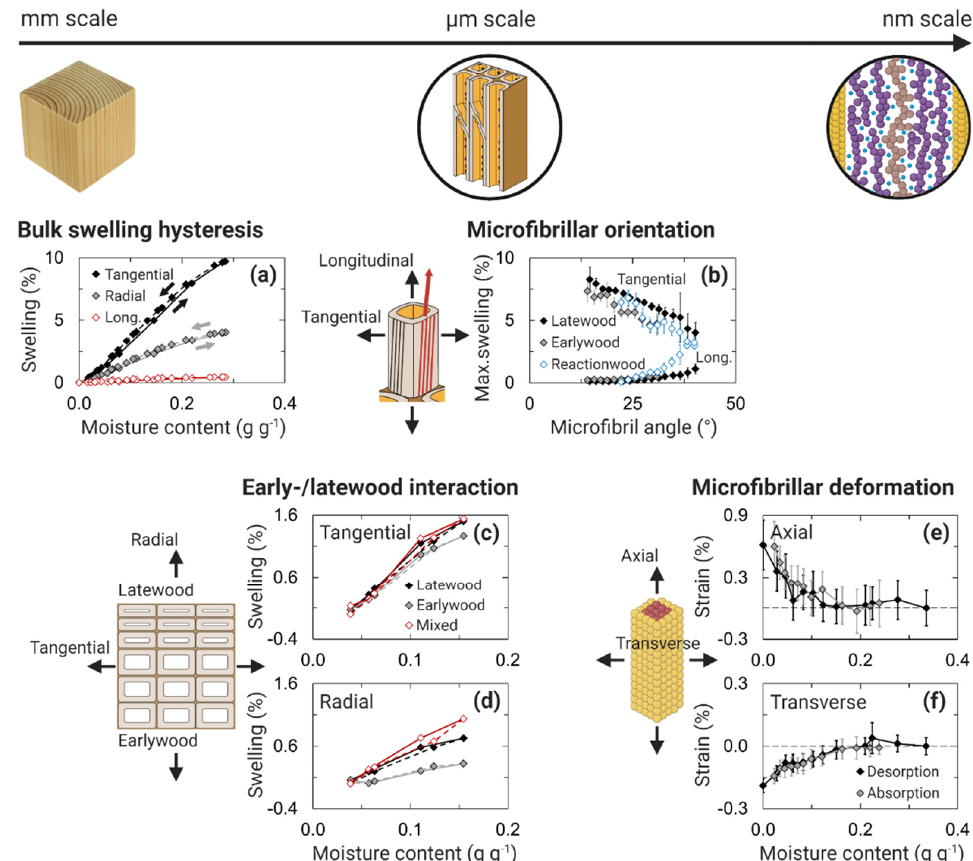
Figure 5. Multiple phenomena involved in the swelling of wood from macro-scale to nano-scale. On the macro-scale, bulk wood exhibits swelling hysteresis ( a ) which results in differences in dimensions at similar moisture contents depending on moisture history (arrows show sorption direction). On the micro-scale, the dominant microfibrillar orientation ( b ), i.e., the microfibril angle, affects the swelling in different directions of the cell (illustrated by the tangential and longitudinal swelling), and the interaction between earlywood tissue and stiffer latewood tissue affects the swelling in the tangential ( c ) and radial ( d ) directions. On the nano-scale, swelling stresses arising from changes in moisture content cause deformation of the cellulose microfibrils in the axial ( e ) and transverse ( f ) directions. Experimental data: ( a ) spruce [146], ( b ) Radiata pine [147], ( c , d ) Norway spruce [148], ( e , f ) Norway spruce [144]. Note that swelling data in ( b ) are calculated from data for the total shrinkage from green to oven-dry conditions, whereas swelling data in ( c , d ) are reported relative to the dimensions in equilibrium with 25% RH and not to those in the dry state.